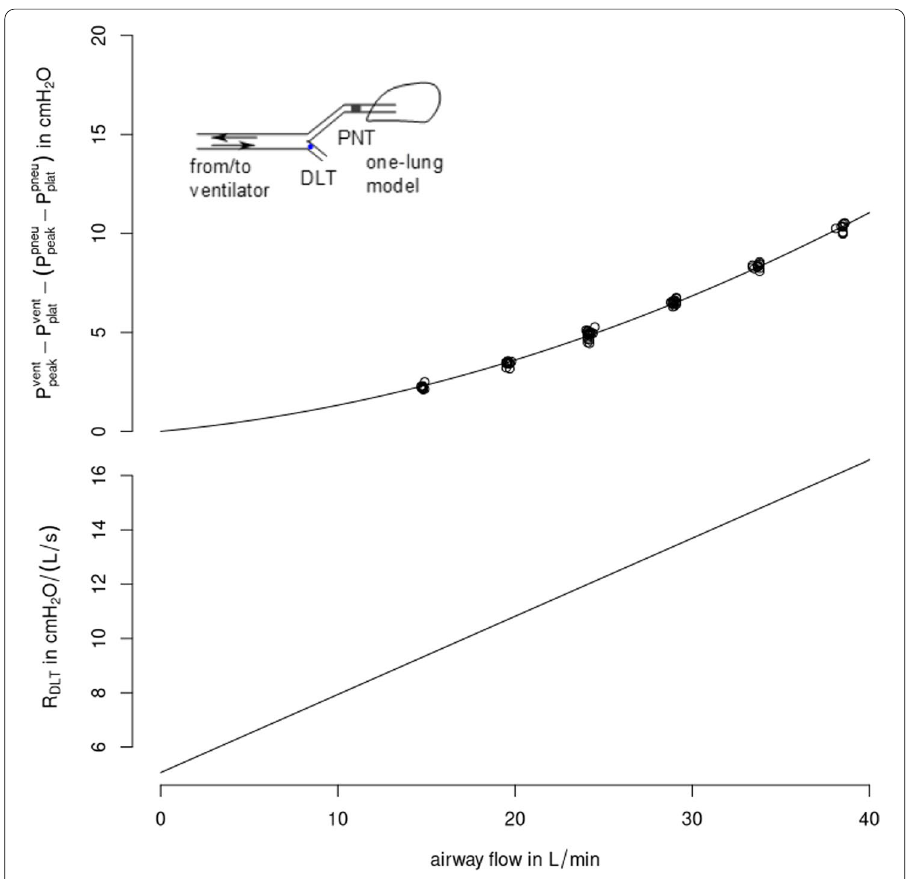
Fig. 1 Measured and modelled pressure drop over double-lumen tube (DLT) resistance from ventilator ( P vent ) to tracheal ( P trach ) measured using a pneumotachograph (PNT) side of the DLT as well as corresponding DLT resistance ( R DLT lower row) over airway